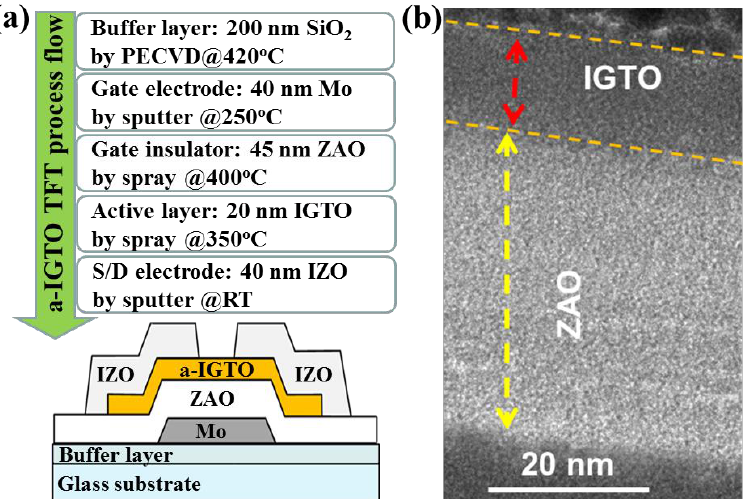
Figure 1. ( a ) Fabrication process flow of IGTO TFT on a glass substrate and schematic representation of the cross-sectional view of IGTO TFT. ( b ) Cross-sectional transmission electron microscopy (TEM) image of spray pyrolyzed IGTO/ZAO stacked film.